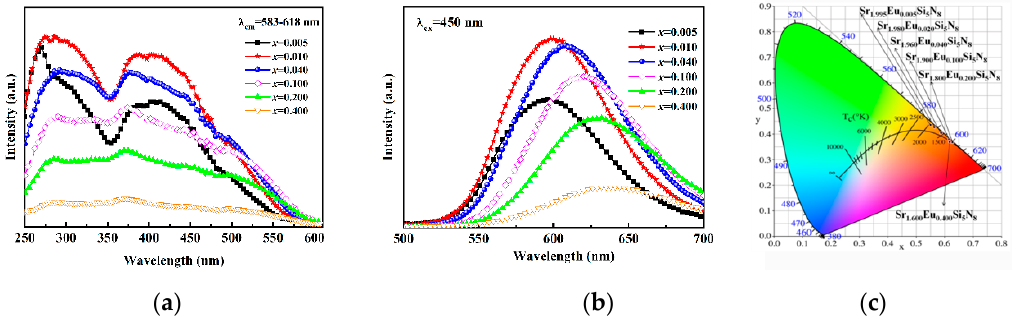
Figure 6. Excitation ( a ) and emission ( b ) spectra of Sr 2 − x Si 5 N 8 : x Eu 2+ phosphors ( x = 0.005, 0.010, 0.040, 0.100, 0.200, 0.400); ( c ) Chromaticity coordinates of Sr 2 − x Si 5 N 8 : x Eu 2+ phosphors with various x values on CIE 1931 chromaticity diagram.